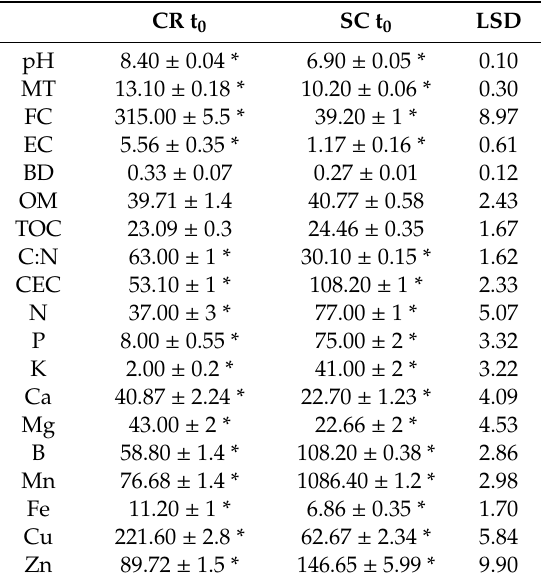
Table 1. Industrial by-products’ characteristics at study initial